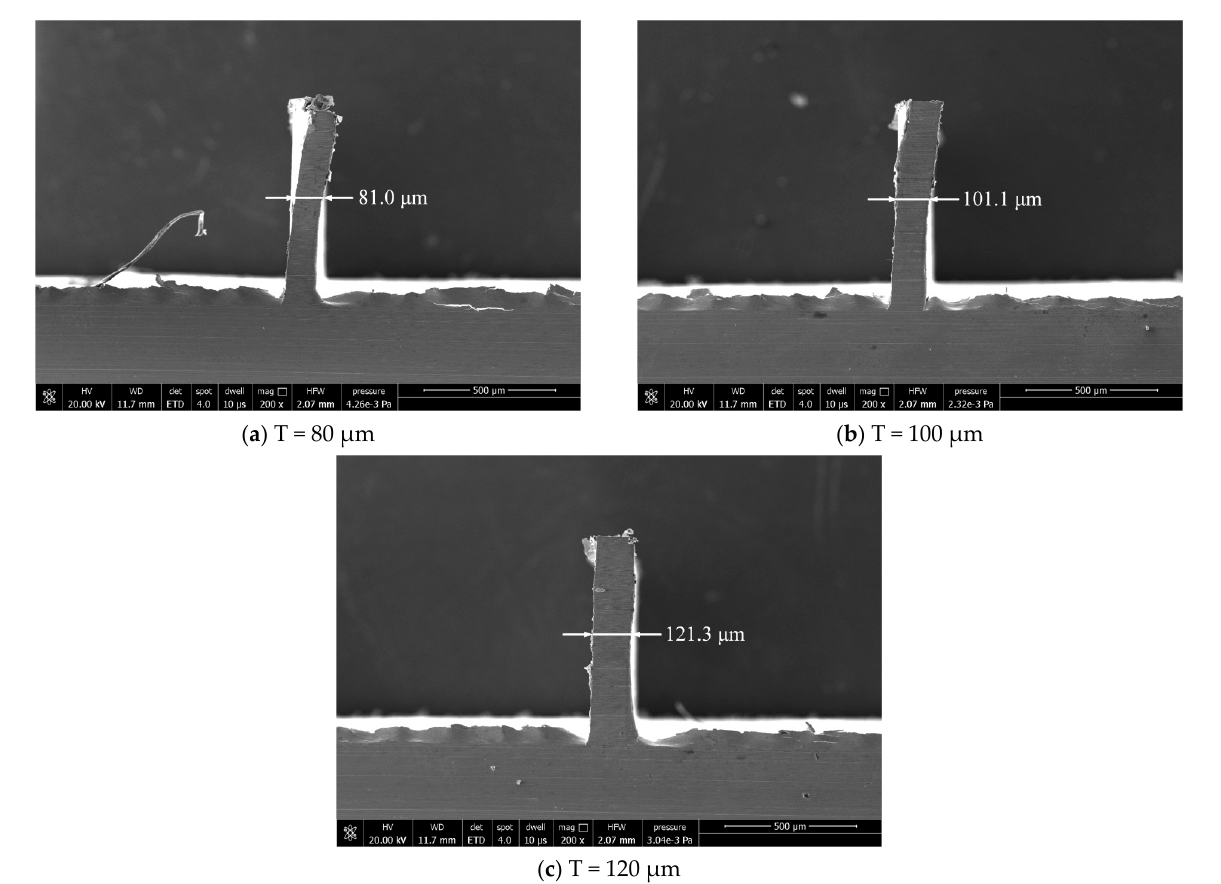
Figure 14. Thin wall measurement results of the first group optimization experiments.